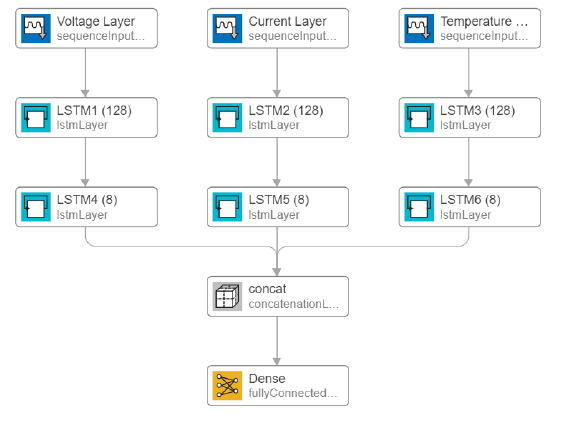
Figure 3. The proposed structure of the RoLSTM model for the SOC estimation. To train the LSTM and update the weights and biases in the network for SOC esti- mation, the Robust and Adaptive online optimization algorithm (RoAdam) is used [33]. RoAdam is dependent on gradient and the squared gradient. The equations of RoAdam are described in (10). The training step size is η = 0.0005; β 1 = 0.9, β 2 = 0.999, and β 3 = 0.999 are exponential decay rates; W t is the weights vector of the model in time step t ; and (cid:101) = 10 − 8 is a constant. The initial values of the first moment of the gradients, m t , and the second moment of the gradients, v t , are zero. r t is defined as a relative prediction error term of the loss